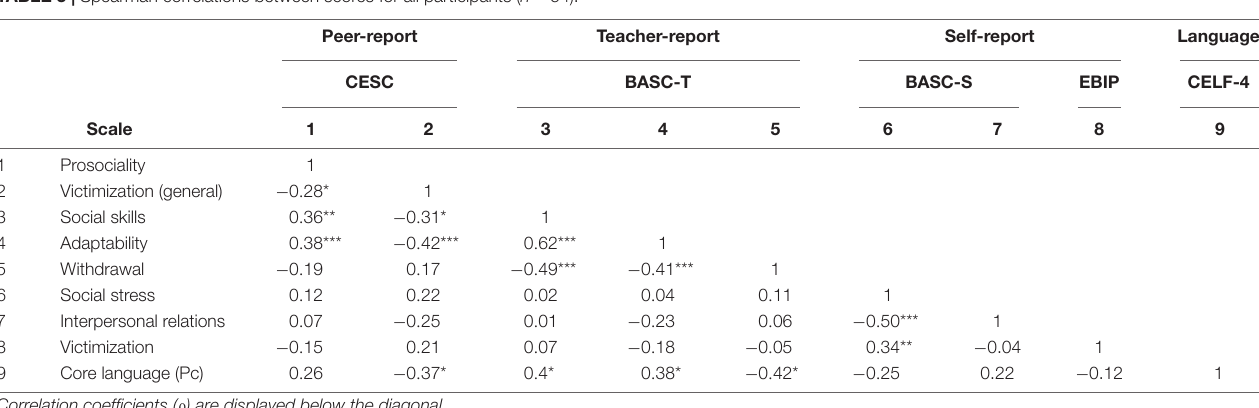
FIGURE 2 | Group boxplots representing the scores on the BASC-T for (A) social skills, (B) adaptability, and (C) withdrawal scores. * p < 0.05. TABLE 3 | Spearman correlations between scores for all participants ( n = 54).